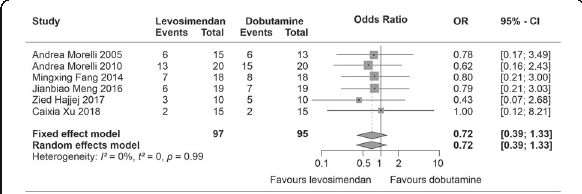
Fig. 1 Meta-analysis of RCTs comparing levosimendan with dobutamine in patients experiencing sepsis-induced cardiac dysfunction. Forest plot of mortality. OR, odds ratio; CI, confidence interval. I 2 = 0%, p = 0.99, fixed effects, OR: 0.72, 95% CnI: 0.39 – 1.33. Figure drawn freely from the data reported by Liu et al.